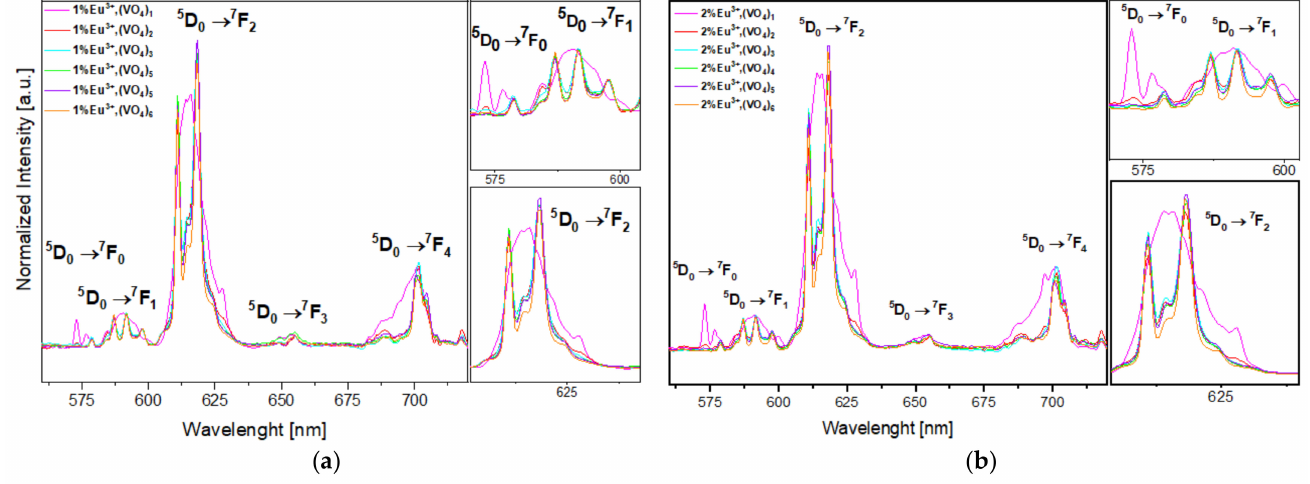
Figure 5. Emission spectra of ( a ) Ca 9.9 Eu 0.1 (PO 4 ) 6 − x (VO 4 ) x (OH) 2 , and ( b ) Ca 9.8 Eu 0.2 (PO 4 ) 6 − x (VO 4 ) x (OH) 2 , where x is equal 1, 2, 3, 4, 5, and 6.The excitation wavelength is equal to 396 nm, a 525 nm filter was used in this